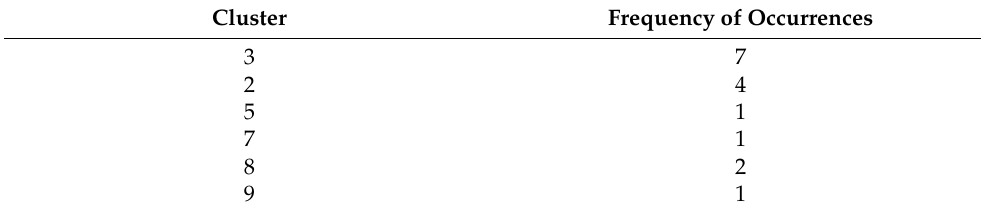
Table 6. Clusters and their frequency of